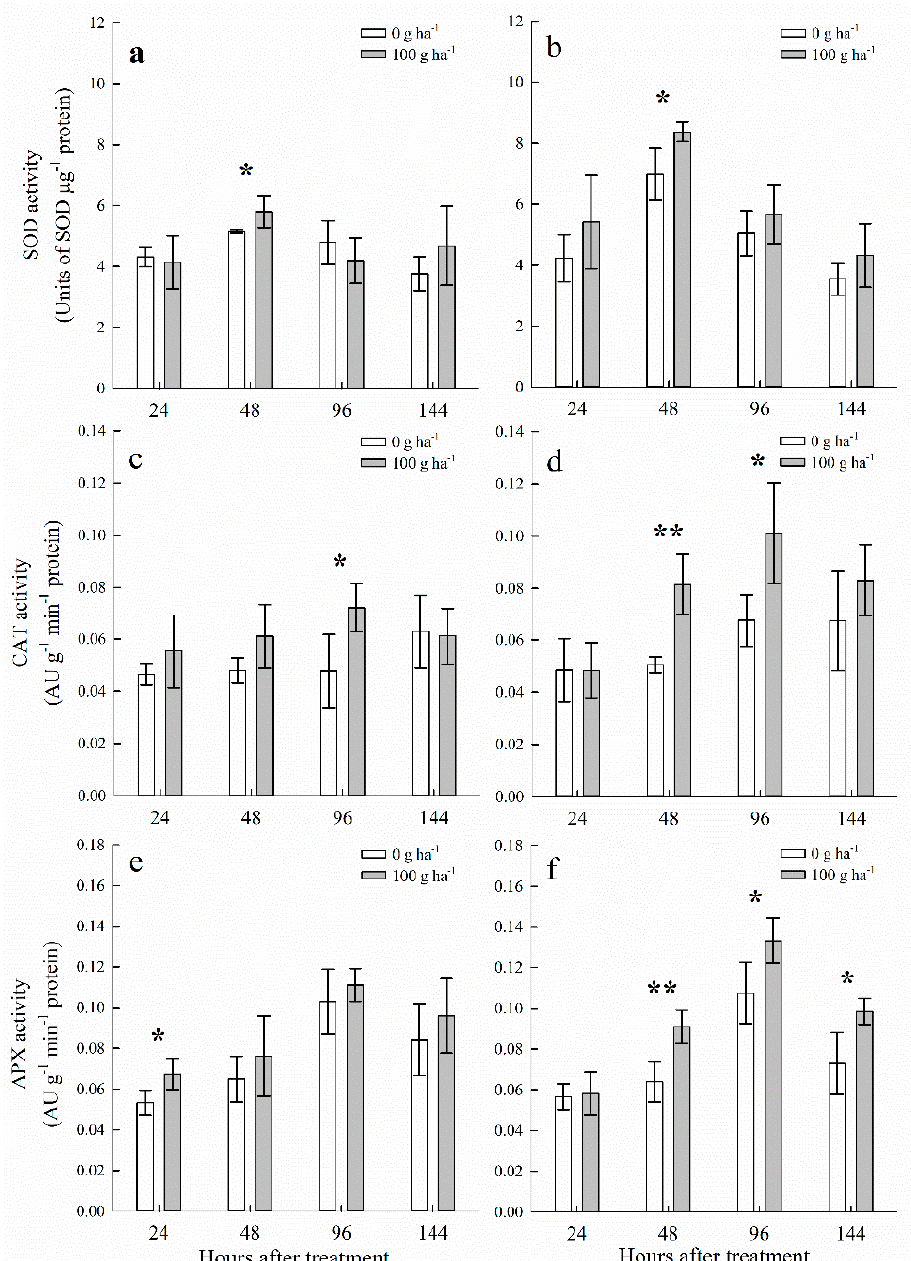
Figure 5. Superoxide dismutase activity (units of SOD µ g − 1 protein; a , b ), catalase activity (units of CAT µ g − 1 protein; c , d ), and ascorbate peroxidase activity (units of APX µ g − 1 protein; e , f ) at 24, 48, 96, and 144 h of Eragrostis plana populations CHK ( a , c , e , no stress) and DRY ( b , d , f , drought) with and without herbicide hours after application of quizalofop. Error bars represent a 95% confidence interval. * t -test ( α = 0.05); ** t -test ( α = 0.01). CAT and APX enzymes are responsible for detoxifying H 2 O 2 in water [53]. Both enzymes are known to act by reducing oxidative stress caused by ACCase-inhibiting herbicides. At 12 HAA of fluazifop-p-butyl, an increase in CAT and APX activities in A. hispidum [10] was seen. After applying clethodim in corn, there was an increase in APX activity of up to 174% [15]. Echinochloa crus-galli resistant to quizalofop had increased catalase activity compared to the susceptible biotype